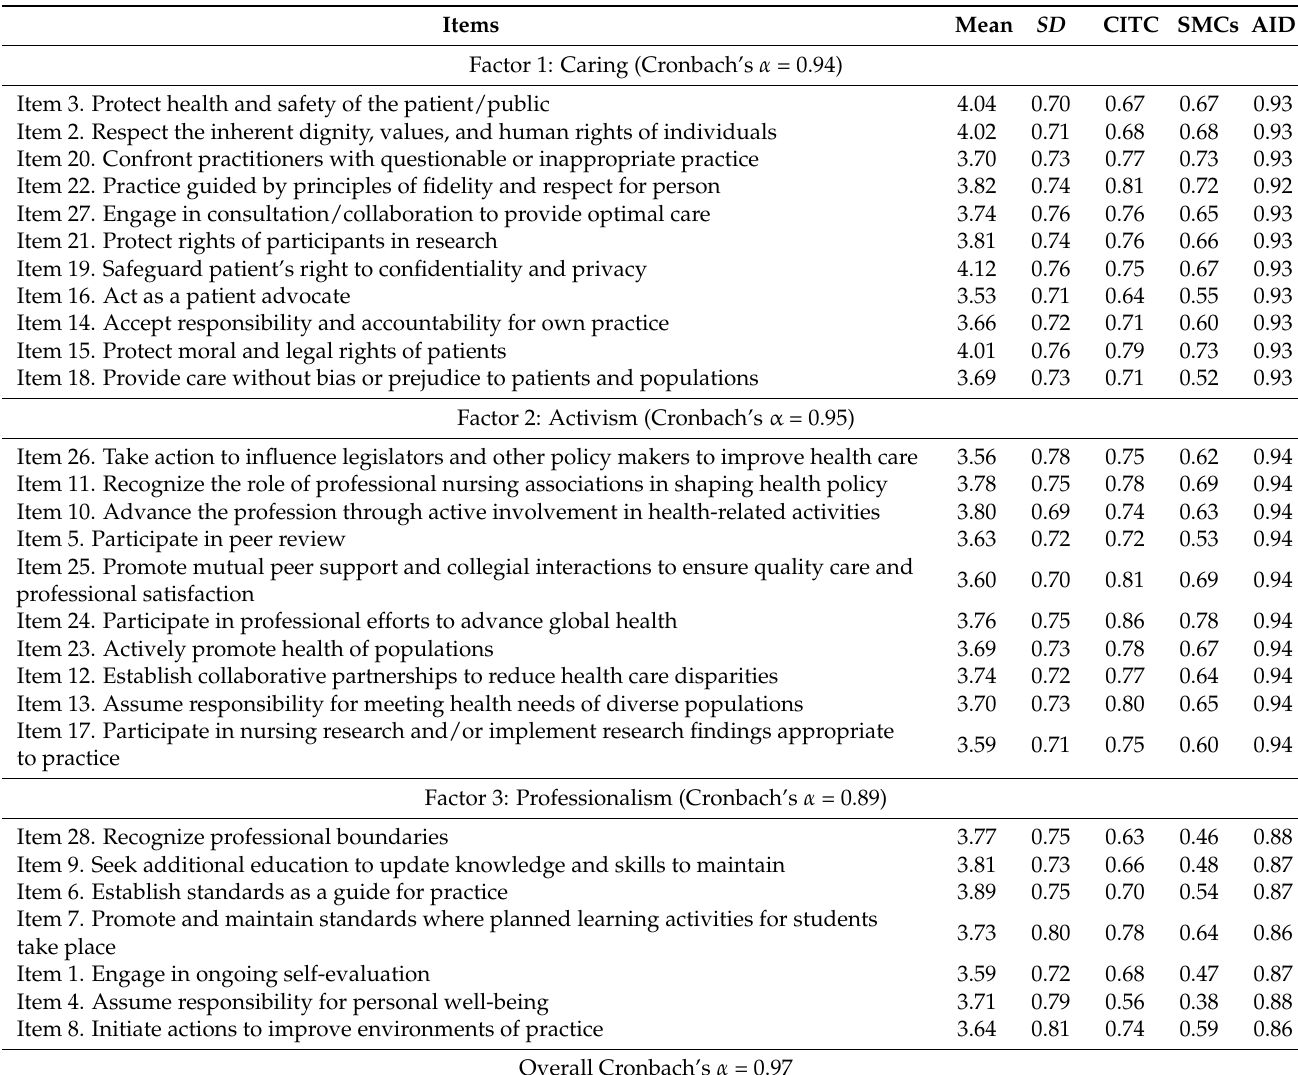
Table 3. Item means, standard deviation, corrected item to total correlations, squared multiple correlations, and alpha if item deleted for the NPVS3-I ( n = 300).